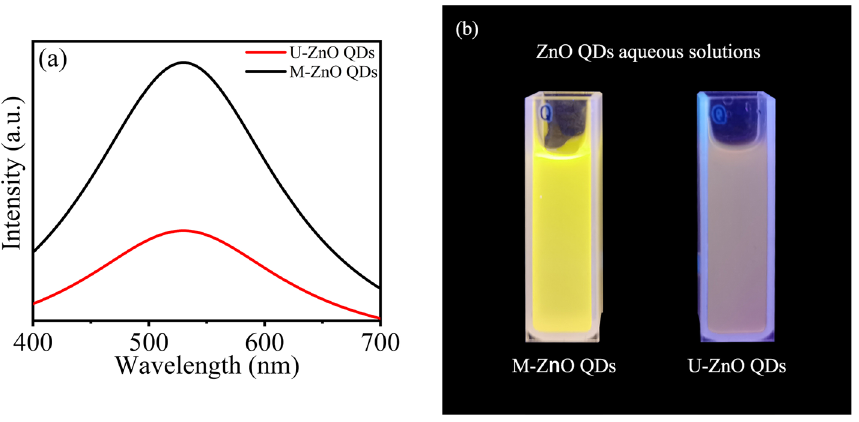
Figure 2. ( a ) The fluorescence spectra of U-ZnO QDs and M-ZnO QDs. ( b ) The fluorescence images of U-ZnO QDs and M-ZnO